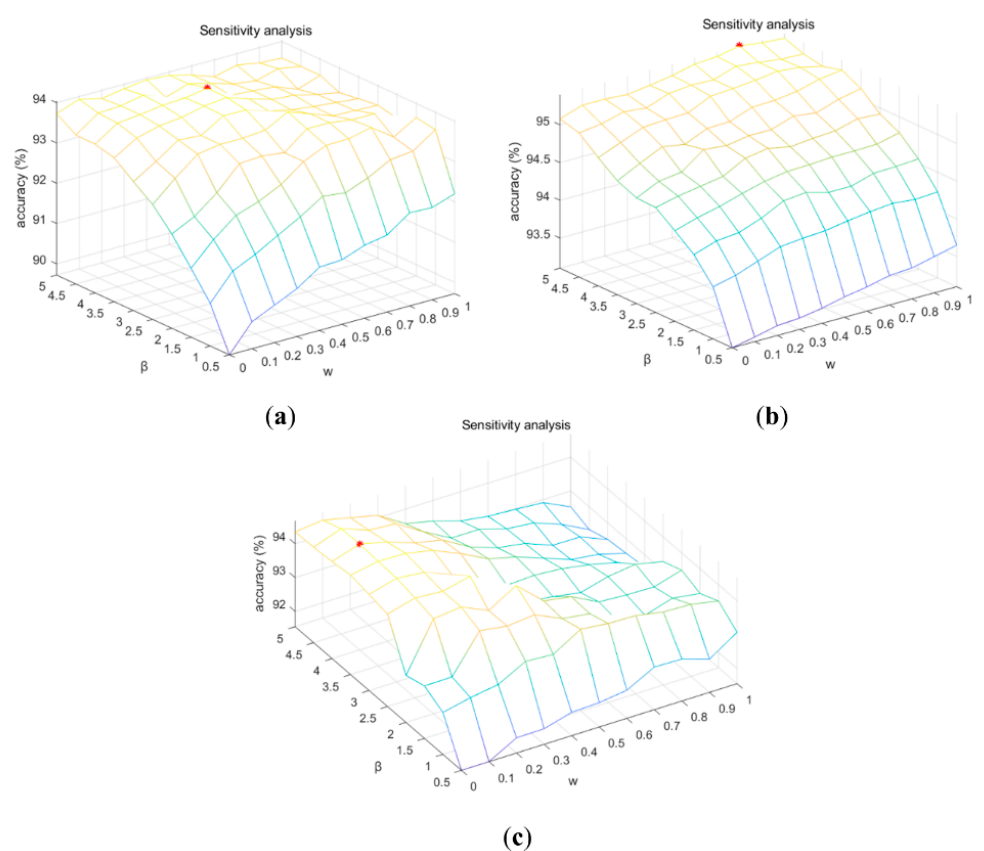
Figure 7. Plots of overall classification accuracies against proportional weighting, w , and smoothing parameter, β , with the maximum value indicated by the red star. ( a ) The MLC-MIX-E method for the ROSIS image (with maximum accuracy achieved at w = 0.5, β = 4), ( b ) the SVM-MIX-E method for the IKONOS image (with maximum accuracy achieved at w = 0.8, β = 5), and ( c ) the MLC-MIX-E method for the Landsat image (with maximum accuracy achieved at w = 0.1, β = 4).